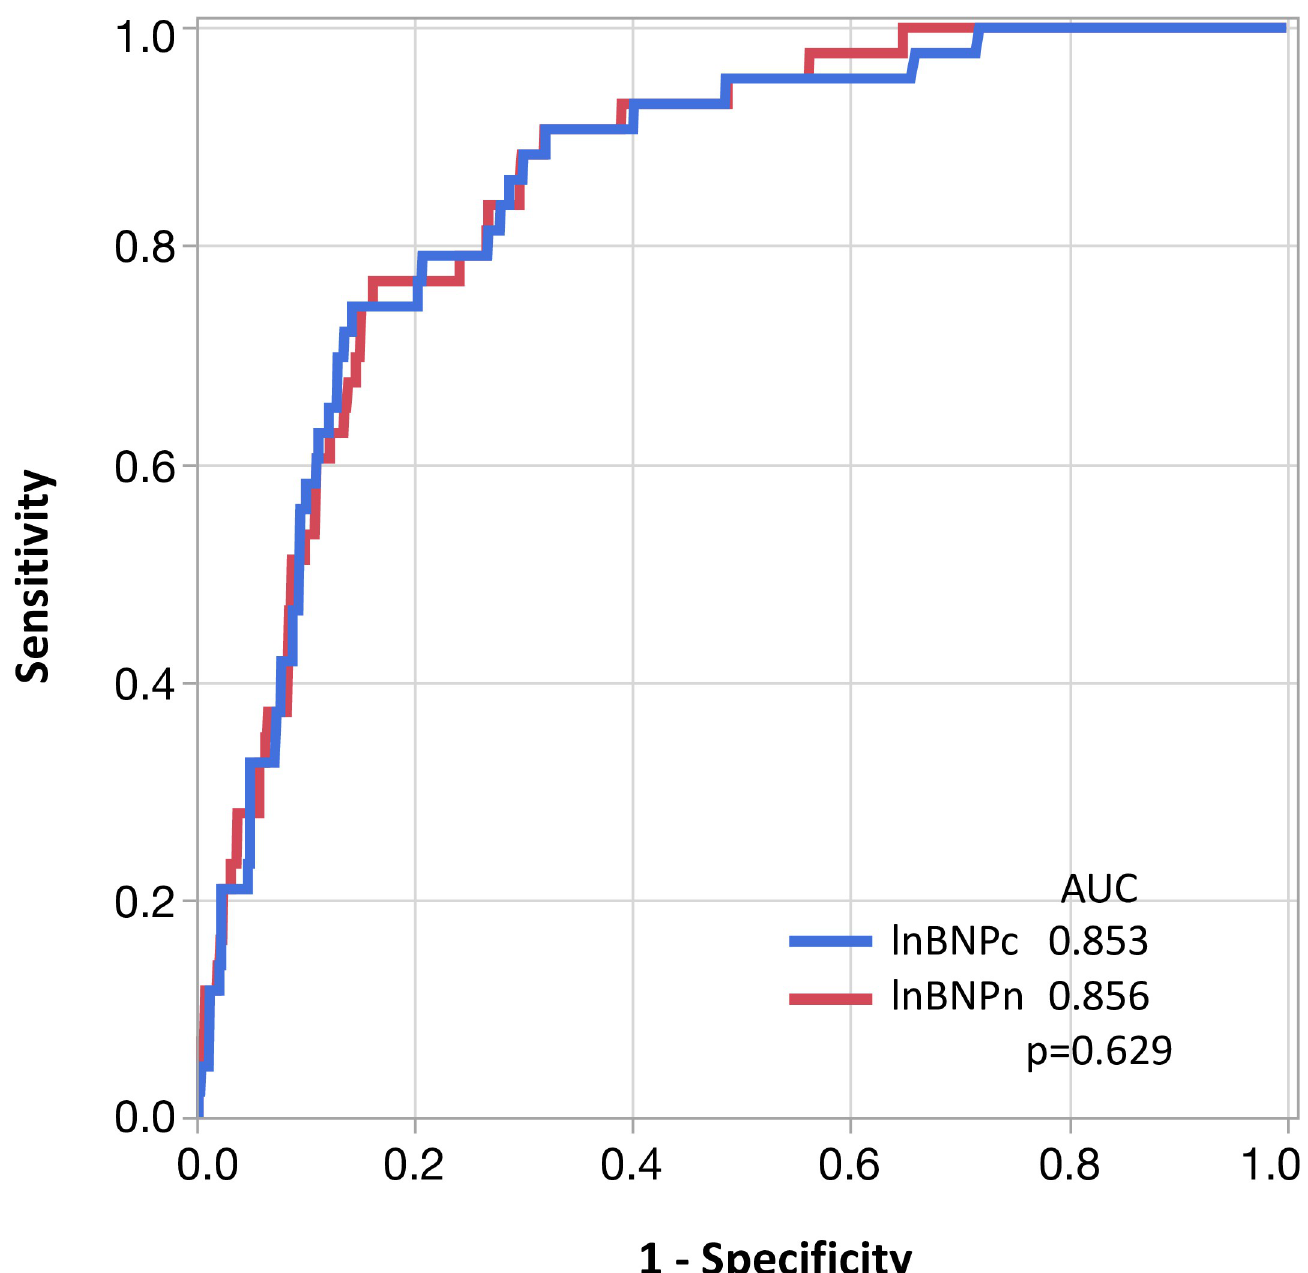
Fig 2. Receiver operation characteristic curves for prediction of cardiac events. Comparison of the area under the curve (AUC) of log-transformed brain natriuretic peptide by the conventional method (BNPc) and the novel method (BNPn) for cardiac events.